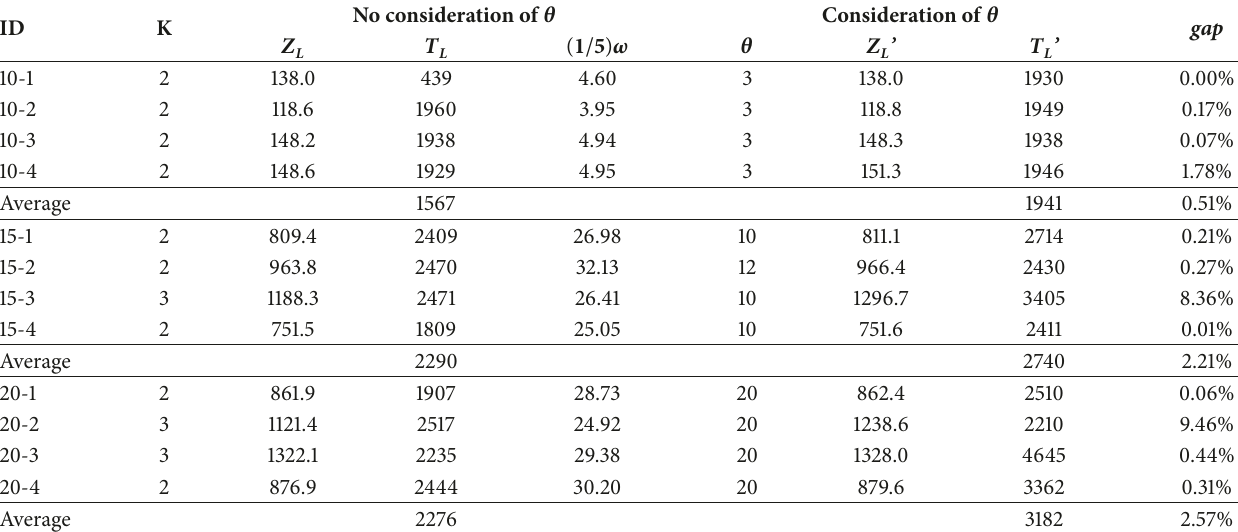
Table 2: sensitivity analysis on workload